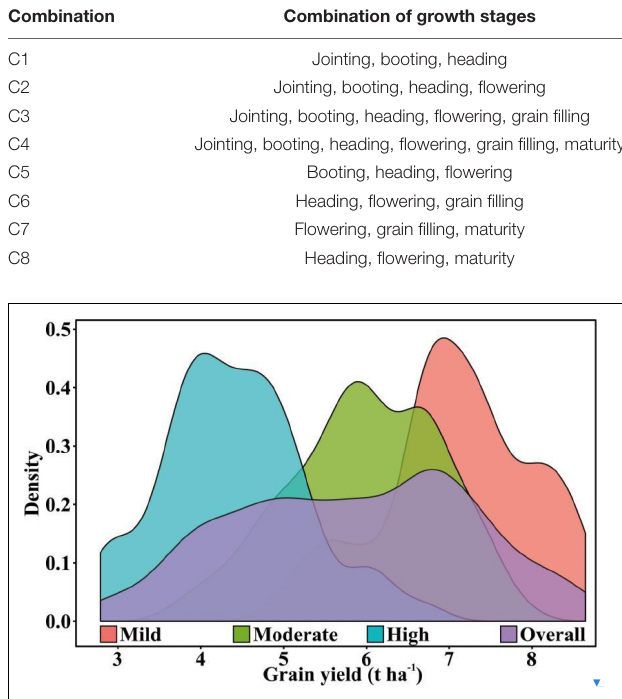
FIGURE 3 | Grain yield distribution curves under various irrigation